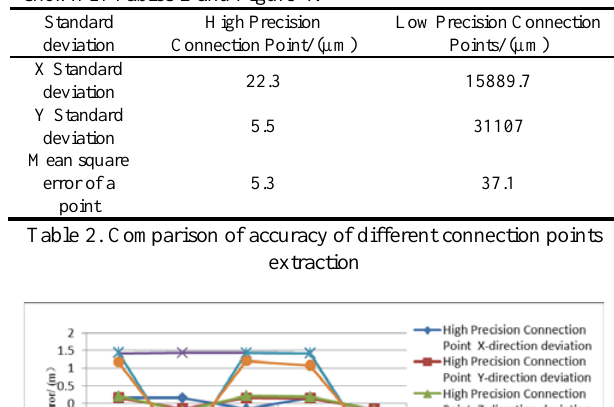
Figure 3. Flight attitude influencing data accuracy broken line 2.2.4